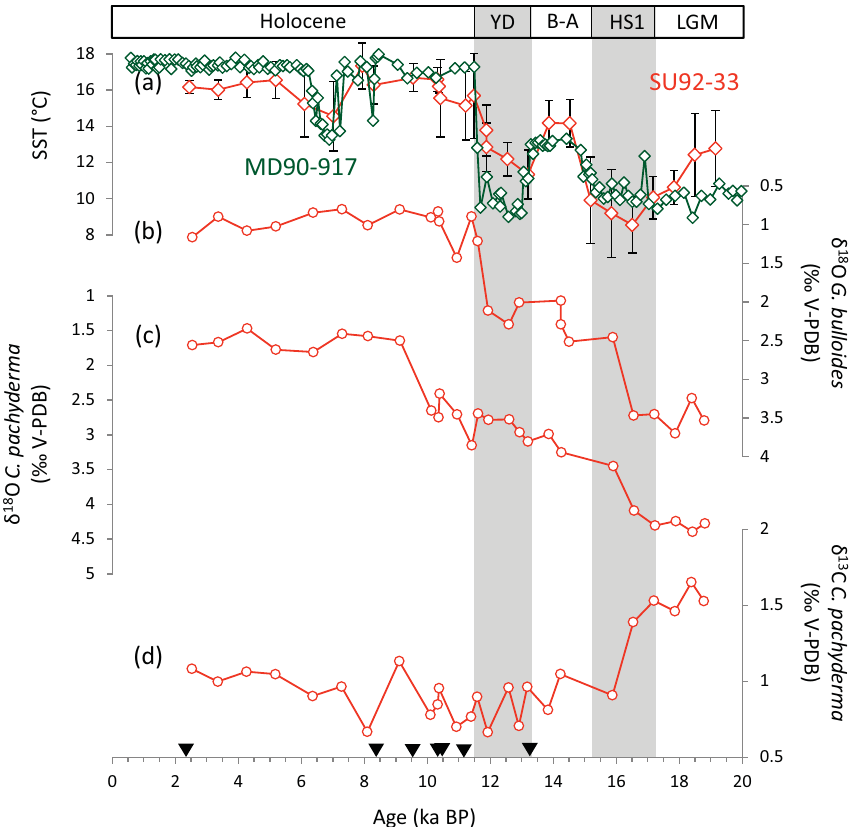
Figure 2. (a) Sea-surface temperature (SST) records of cores SU92-33 (red line) and MD90-917 (green line; Siani et al., 2004), (b) δ 18 O record obtained on planktonic foraminifer G. bulloides for core SU92-33, (c) δ 18 O record obtained on benthic foraminifer C. pachyderma for core SU92-33 and (d) δ 13 C record obtained on benthic foraminifer C. pachyderma for core SU92-33. LGM is Last Glacial